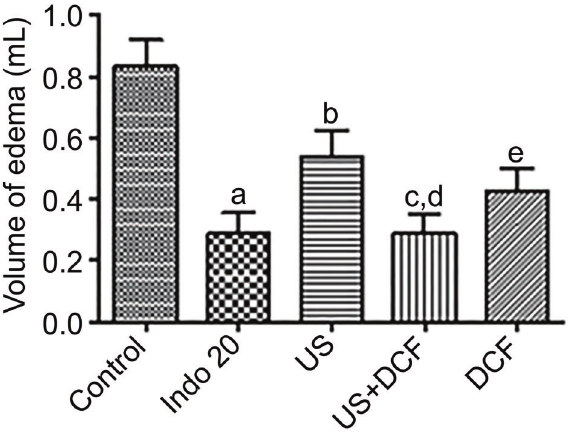
Figure 3. Evaluation of acute treatment with diclofenac (DCF) or ultrasound-associated DCF (US + DCF), and US on thermal nociception in cutaneous hyperalgesia (Hargreaves ’ s test) in the third hour (T3). Data are reported as mean ± SE. Indometha- cin 20 mg/kg ( po ) (INDO 20) was used as reference drug. a P o 0.05; b P o 0.01; c P o 0.001 vs control